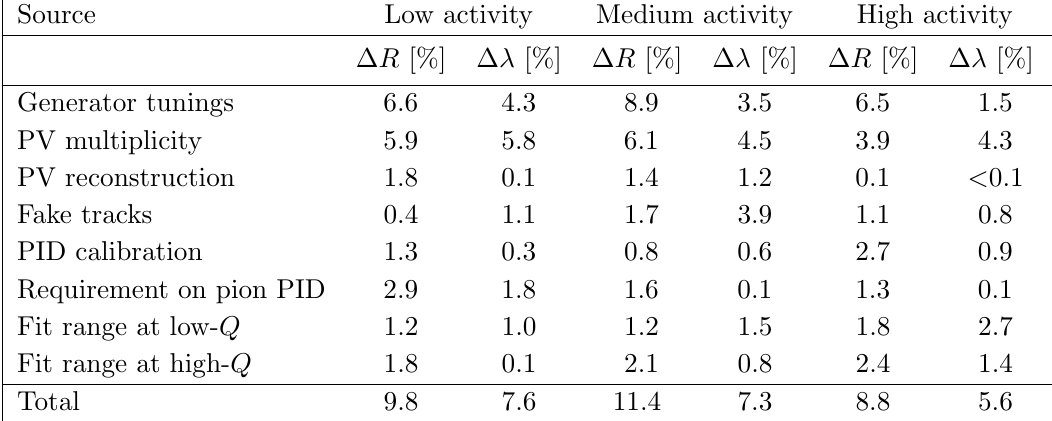
Table 1 . Fractional systematic uncertainties on the R and (cid:21) parameters for the three activity classes, as described in the text. The total uncertainty is the sum in quadrature of the individual contributions.